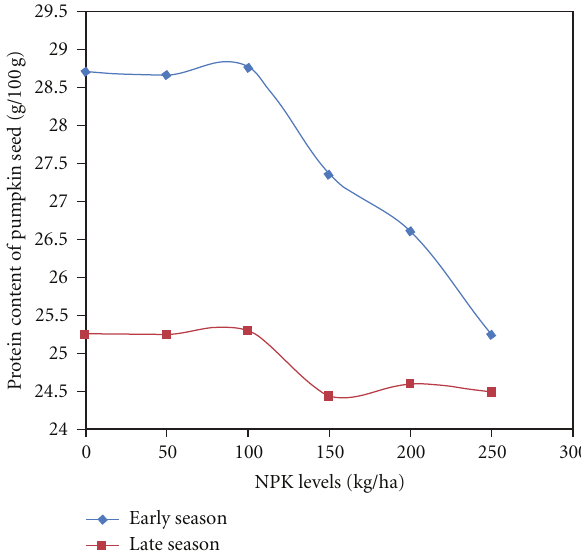
Figure 1: Protein content of pumpkin seeds as a ff ected by season by NPK fertilizer.